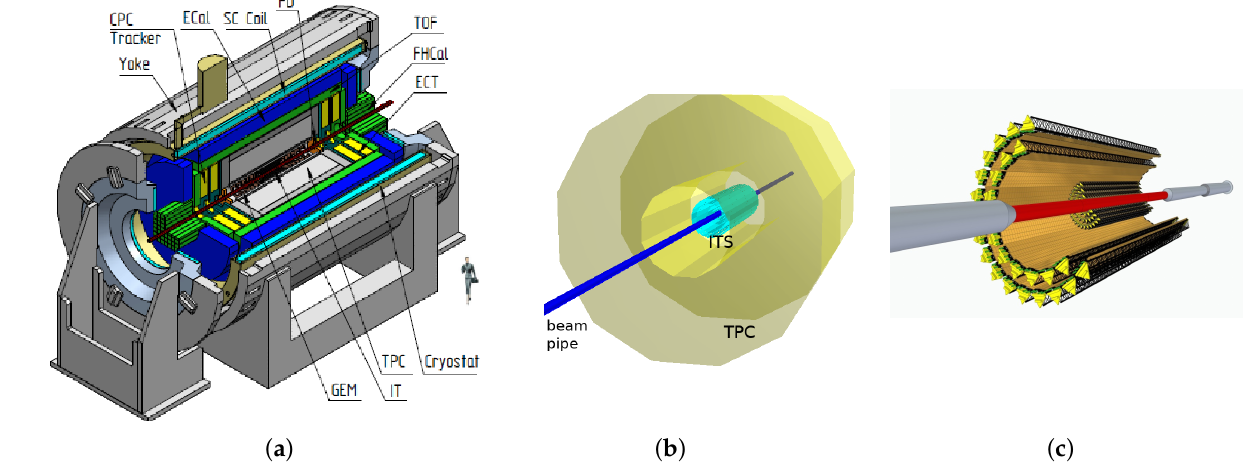
Figure 1. ( a ) Three-dimensional view of the MPD detector. ( b ) Beam pipe, TPC and ITS geometry representation in the simulation package. ( c ) Technical drawing of the ITS cut view [10]: shown are the beam pipe, three inner layers with an effective thickness of 50 µ m of Si and two outer layers with an effective thickness of 700 µ m of Si. Average layer radii are 24, 43, 63, 146 and 196